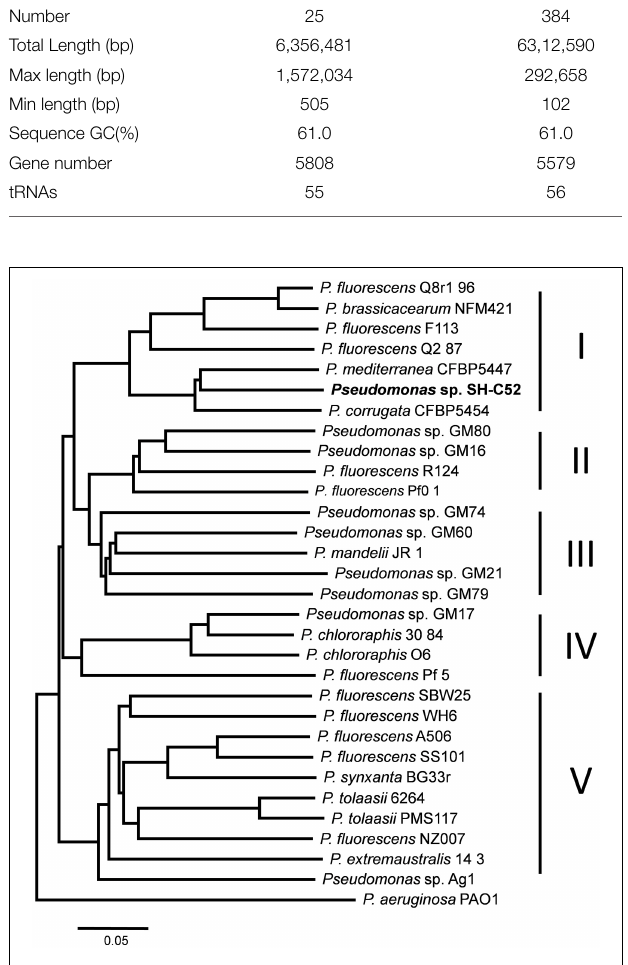
FIGURE 1 | Whole genome phylogenetic analysis of Pseudomonas sp. SH-C52. Phylogenetic tree constructed by use of CVtree, and based on the analysis performed previously by Redondo-Nieto et al. (2012), with the addition of strains SH-C52, P. corrugata CFBP5454 and P. mediterranea CFBP5447.